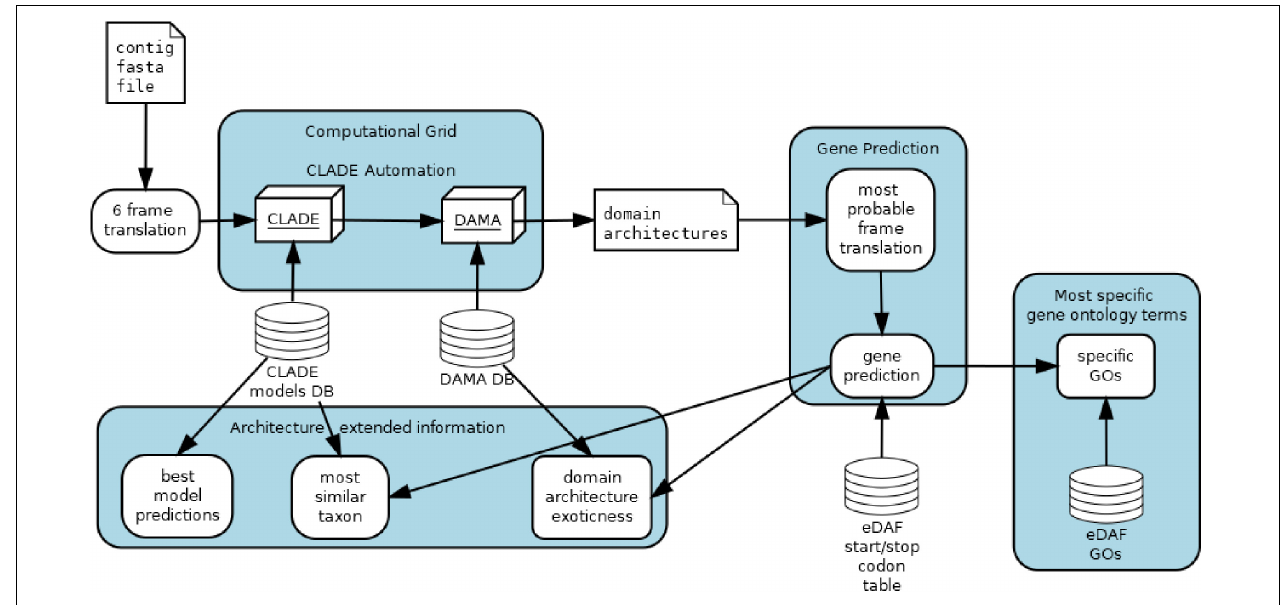
FIGURE 1 | eDAF flow